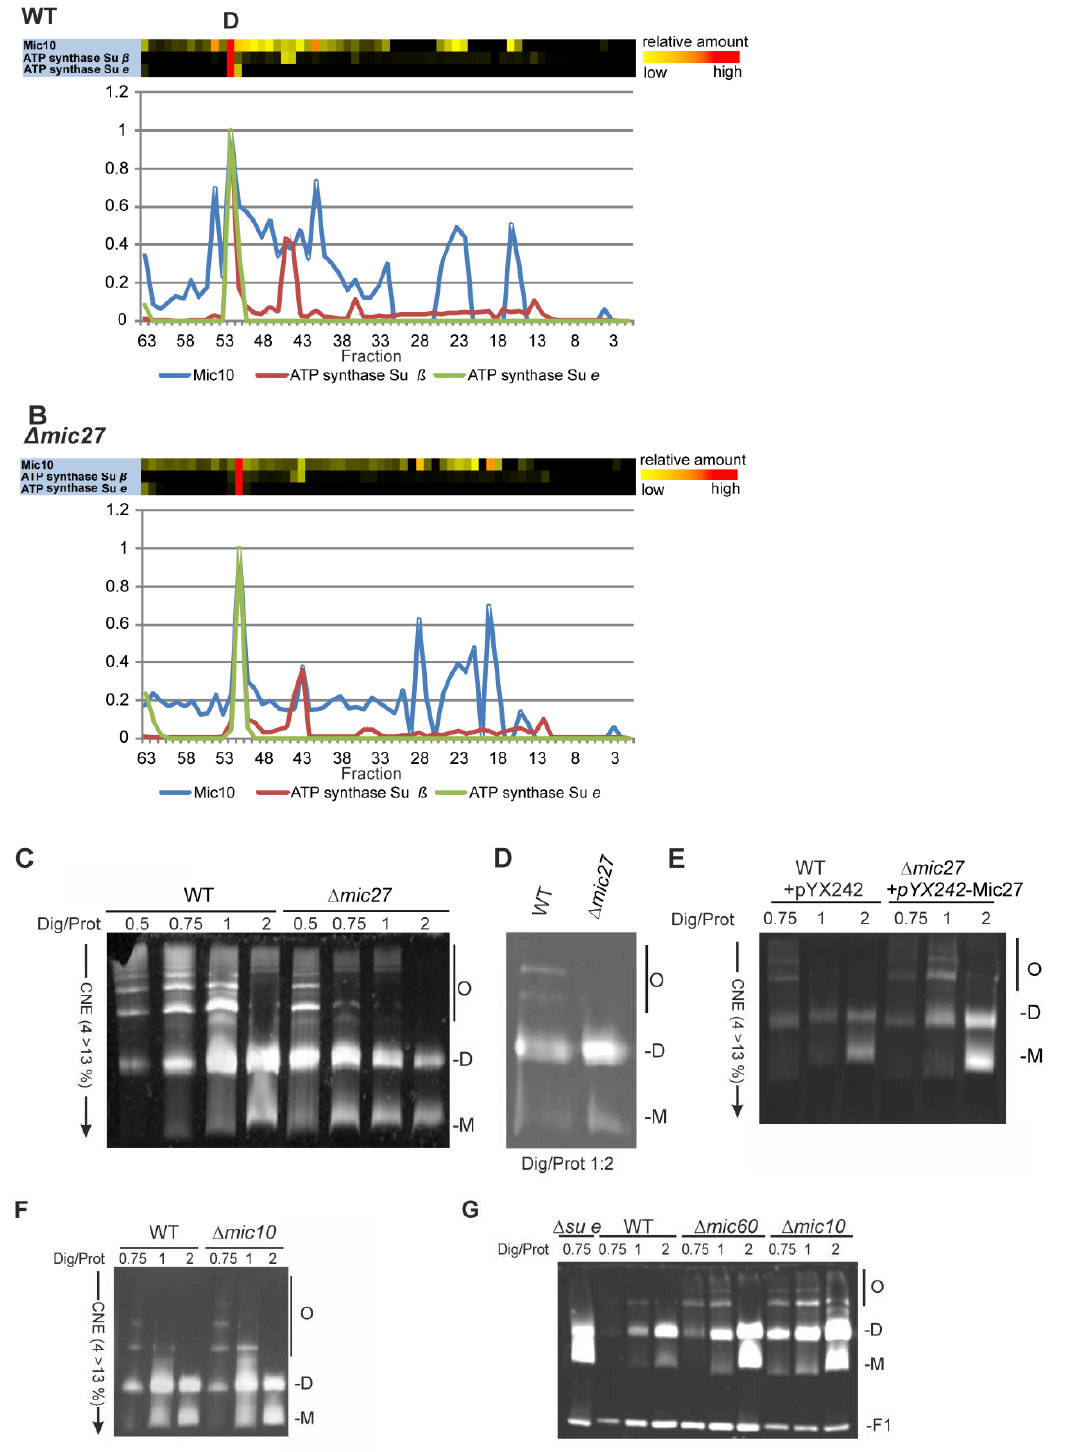
FIGURE 4: Mic27 and Mic10 modulate assembly of F 1 F O ATP synthase oligomers in an antagonistic manner. (A,B) Mic10 comigrates with the dimer- ic F 1 F O ATP synthase irrespective of the presence of Mic27. Complexome distribution profiles of Mic10, F 1 F O ATP synthase subunit β, and the dimer- specific F 1 F O ATP synthase subunit e in wildtype (A) and Δ mic27 (B) mitochondria (details see Figure 2). (C-E) Mic27 promotes the assembly of the F 1 F O ATP synthase oligomers. (C,D) Isolated mitochondria of a wildtype (WT) and a Δ mic27 yeast strain were solubilized with the indicated ratios of digitonin to protein and separated by CN-PAGE and subsequently in-gel staining of F 1 F O -ATP synthase activity was performed. (E) Effect of Mic27 overexpression on assembly of the F 1 F O ATP synthase. Indicated strains were analyzed as in panels C,D. Overexpression of Mic27 was confirmed by Western blot analysis (see SFig. 1C,). (F,G) Mic10 moderately impairs the assembly of the F 1 F O ATP synthase oligomers. Indicated strains were ana- lyzed as in panels C,D. Strains lacking the F 1 F O ATP synthase subunit e or Mic60 were used as controls in panel G. Monomers (M), dimers (D), oligo- mers of the F 1 F O -ATP synthase (O), and the F1 part (F1) of the F 1 F O ATP synthase are